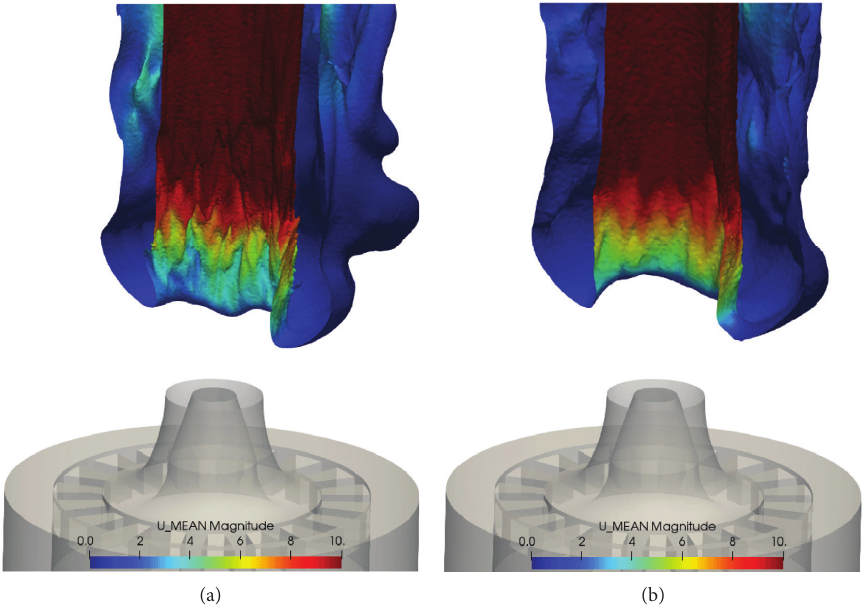
Figure 18: Contour of mean temperature T